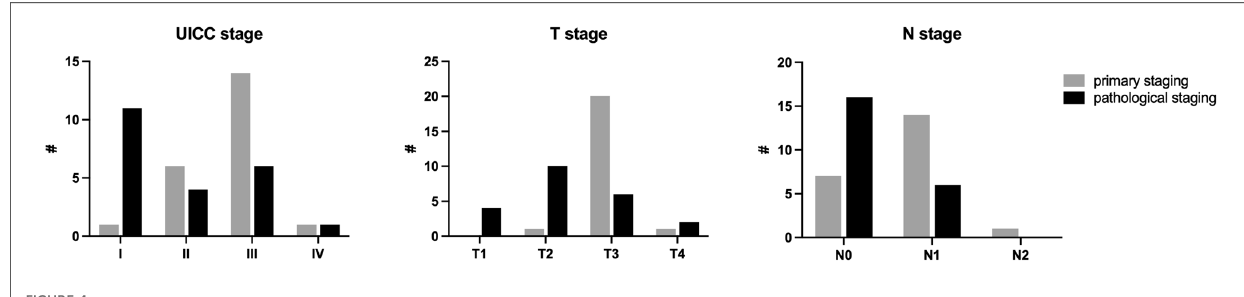
FIGURE 4 UICC, T and N stage in primary staging and pathological fi